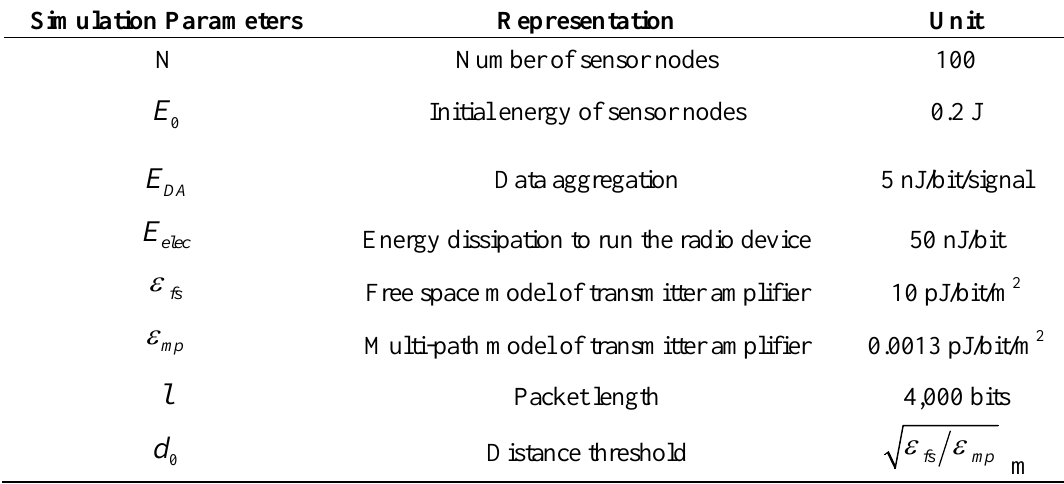
Table 1. Simulation